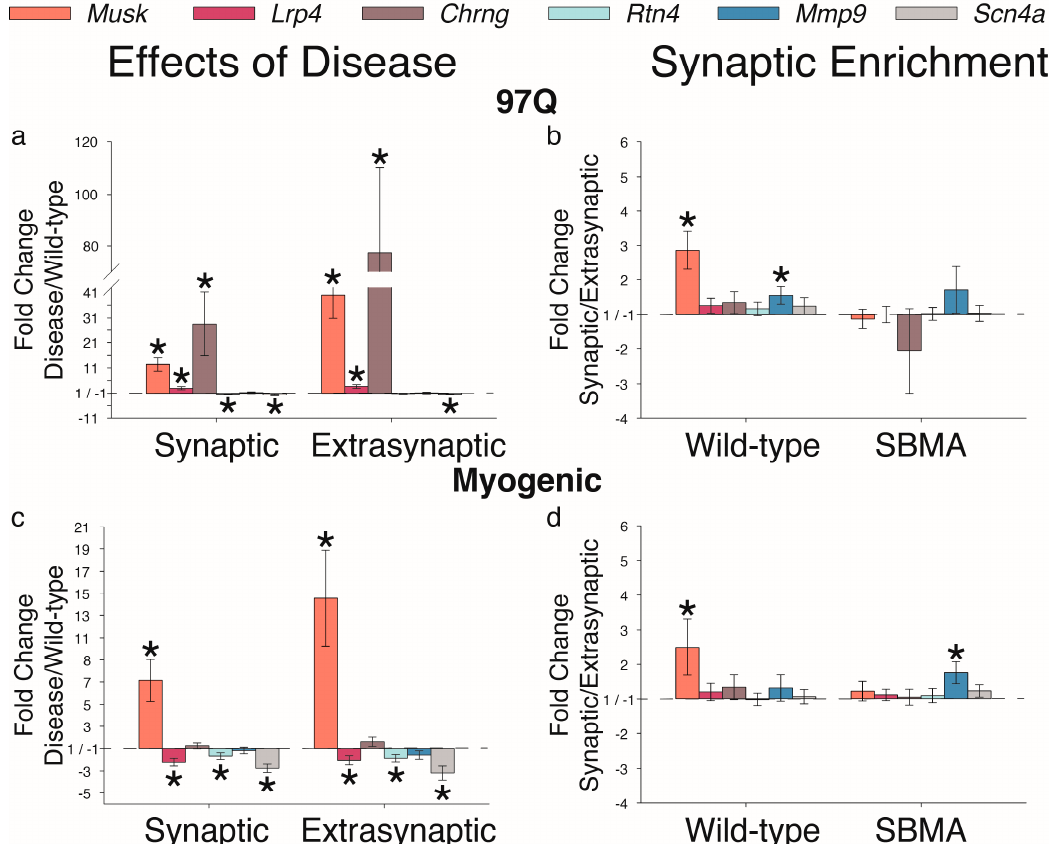
Figure 5. Disease affects genes implicated in synaptic stability and function. ( a , c ) With few exceptions, synaptic-related genes are affected by disease in one or both disease models. Changes include a marked increase in Musk , which encodes a receptor tyrosine kinase for the AChR-stabilizing agrin, and Chrng , encoding the neonatal subunit of the AChR. Disease also affects Lrp4 in both models although in divergent directions—being increased in the 97Q model while decreased in myogenic model. Other significant and consistent changes in transcript levels include a downregulation of Rtn4 , encoding an inhibitory signal for axonal sprouting, and Scn4a , encoding the sodium voltage-gated channel alpha subunit 4, the adult isoform which controls the influx of sodium into muscle cells. ( b , d ) Notably, the synaptic enrichment of Musk is also lost with disease. Thus, the challenges of disease seem to trigger an adaptive response to maintain and/or rescue neuromuscular synaptic function by reverting back to a permissive environment for axon sprouting (by downregulating Rtn4) and by increasing AChR expression and recruiting and stabilizing these newly made AChRs at the synapse (by upregulating Musk and Chrng ). These data underscore the general theme that many genes important for synaptic stability are dysregulated in muscles of SBMA mice, possibly explaining the characteristic deficit in synaptic strength. Fold changes ± SEM are shown relative to wild-type ( a , c ) or extrasynaptic ( b , d ) samples; Statistical analysis was based on pair-wise fixed reallocation randomization test: * p < 0.05.